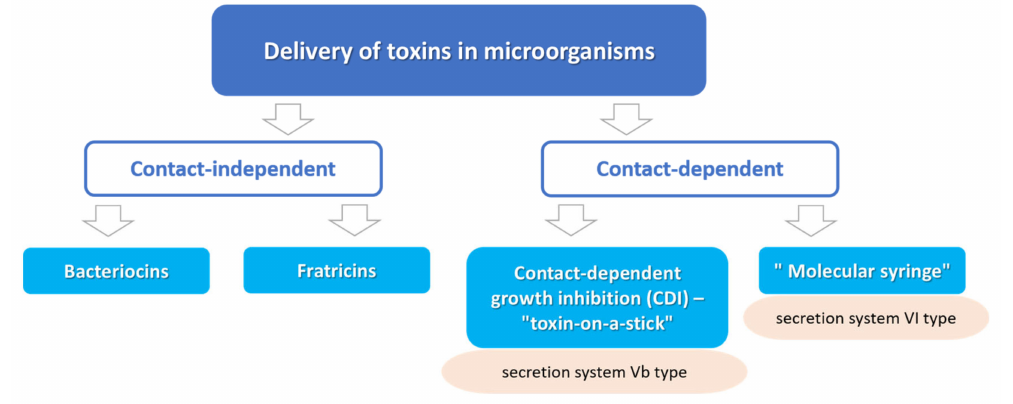
Figure 1. Delivery of toxin e ff ectors into target cells in